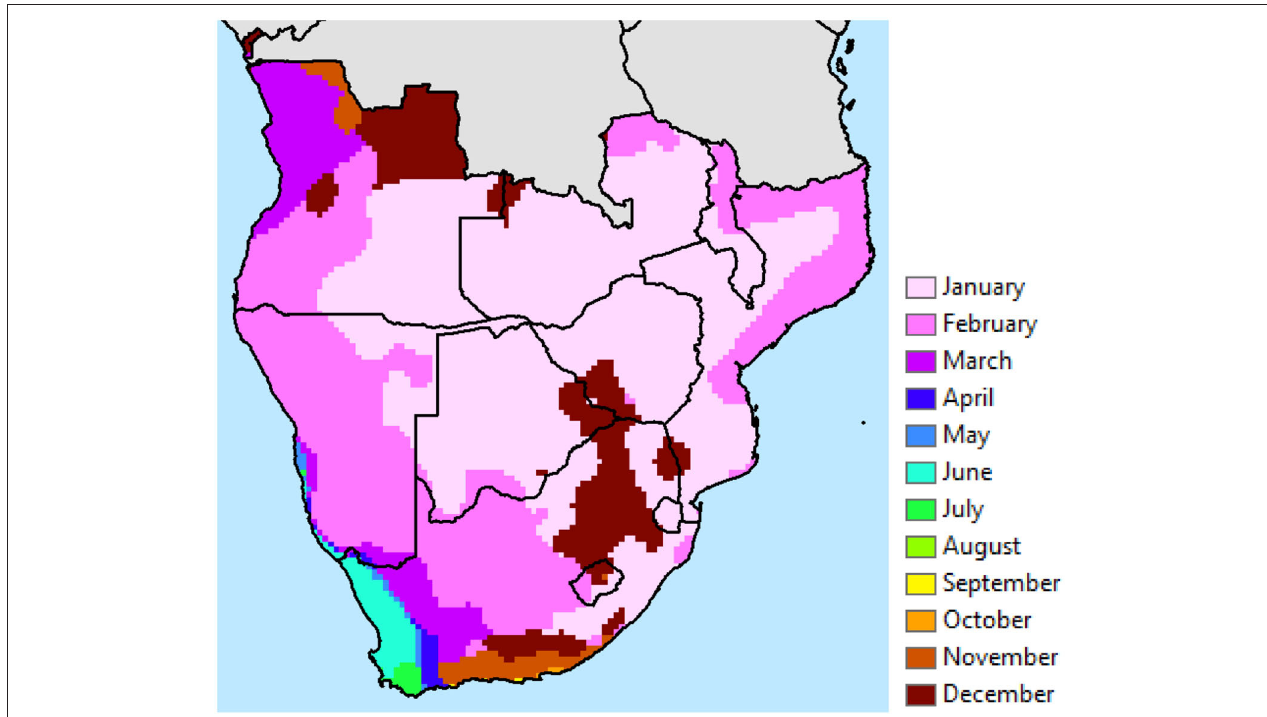
FIGURE 5 | Middle month of wettest 3 months, 1981–2000. Source: Authors’ calculations based on Princeton Global Forcings, version 3 [2018, based on Sheffield et al. (2006)].